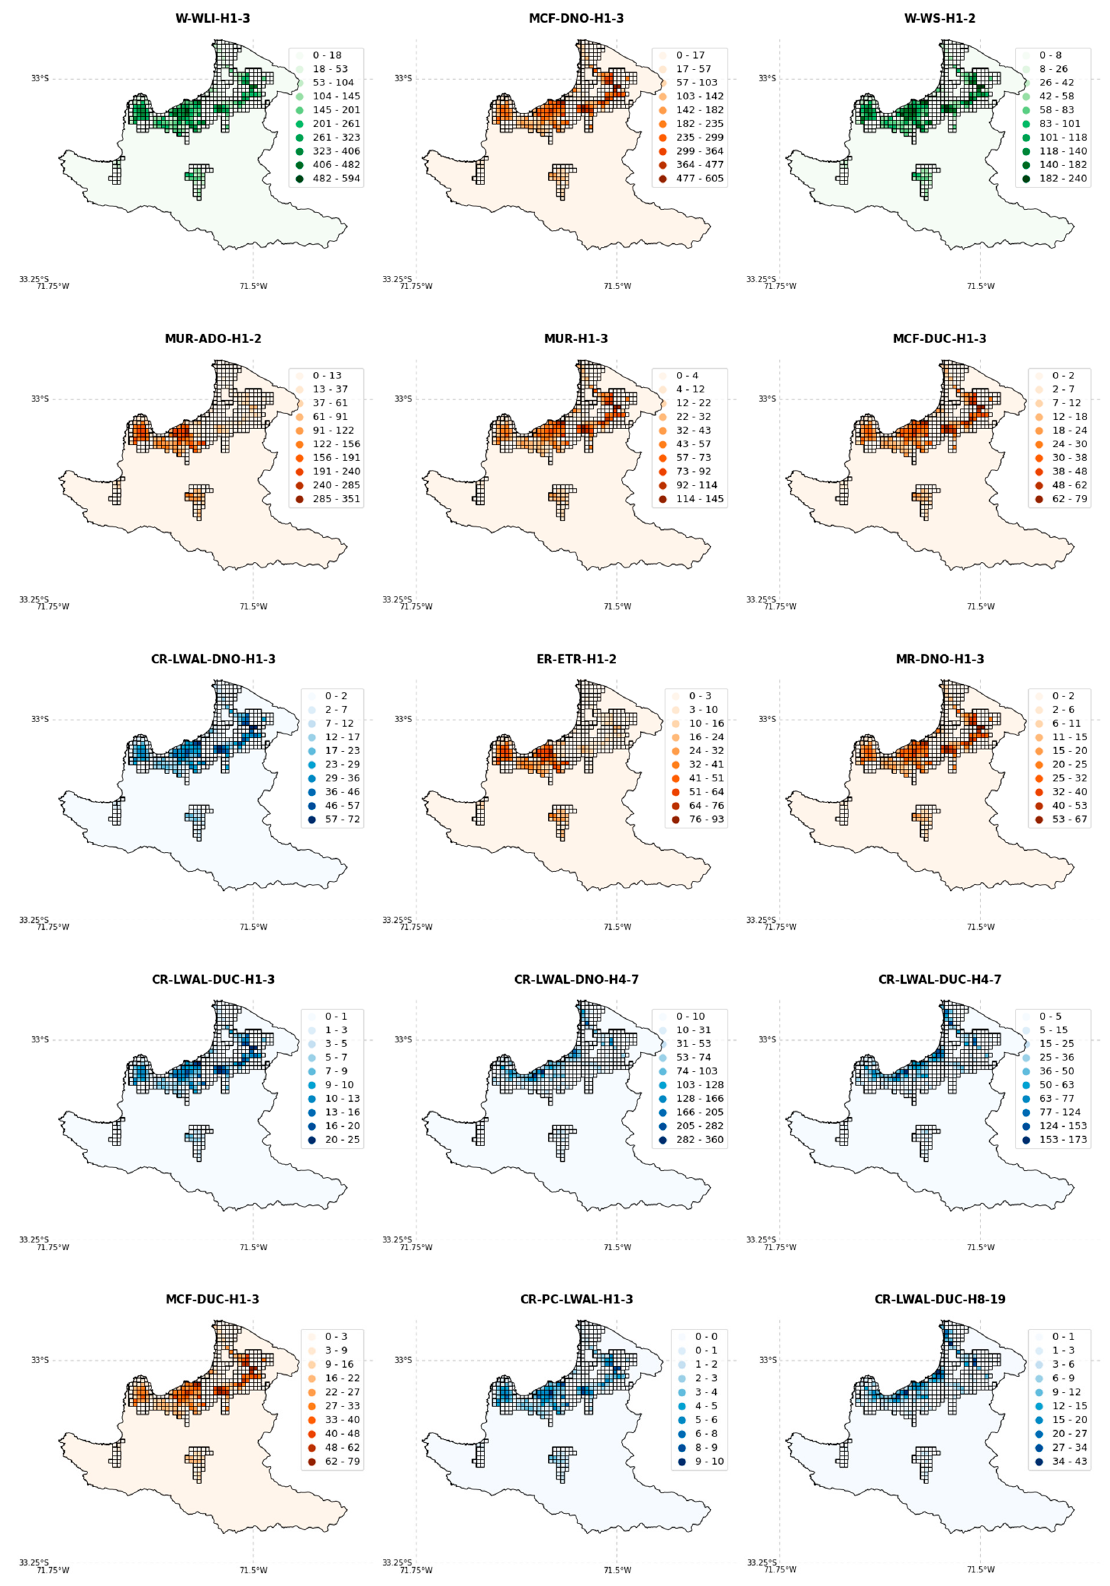
Figure 10. Spatial distributions of the building counts for the SARA typologies obtained from the probabilistic model in Valparaíso. The colour scale was selected in terms of the material type (green = wooden; orange = masonry; blue = reinforced concrete).